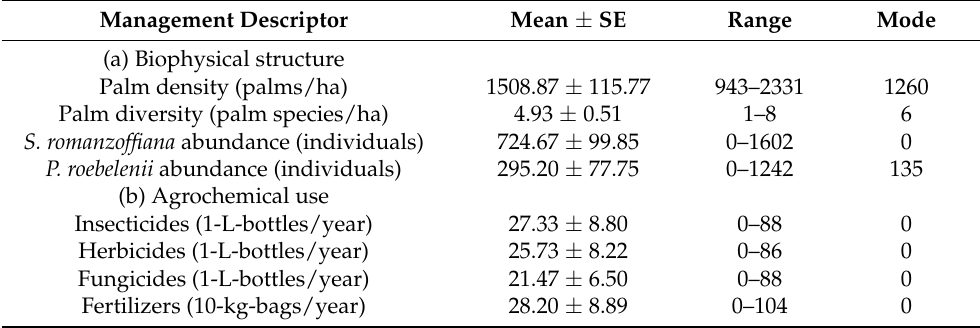
Table 2. Local characteristics of agricultural management in ornamental palm plantations in central Veracruz,